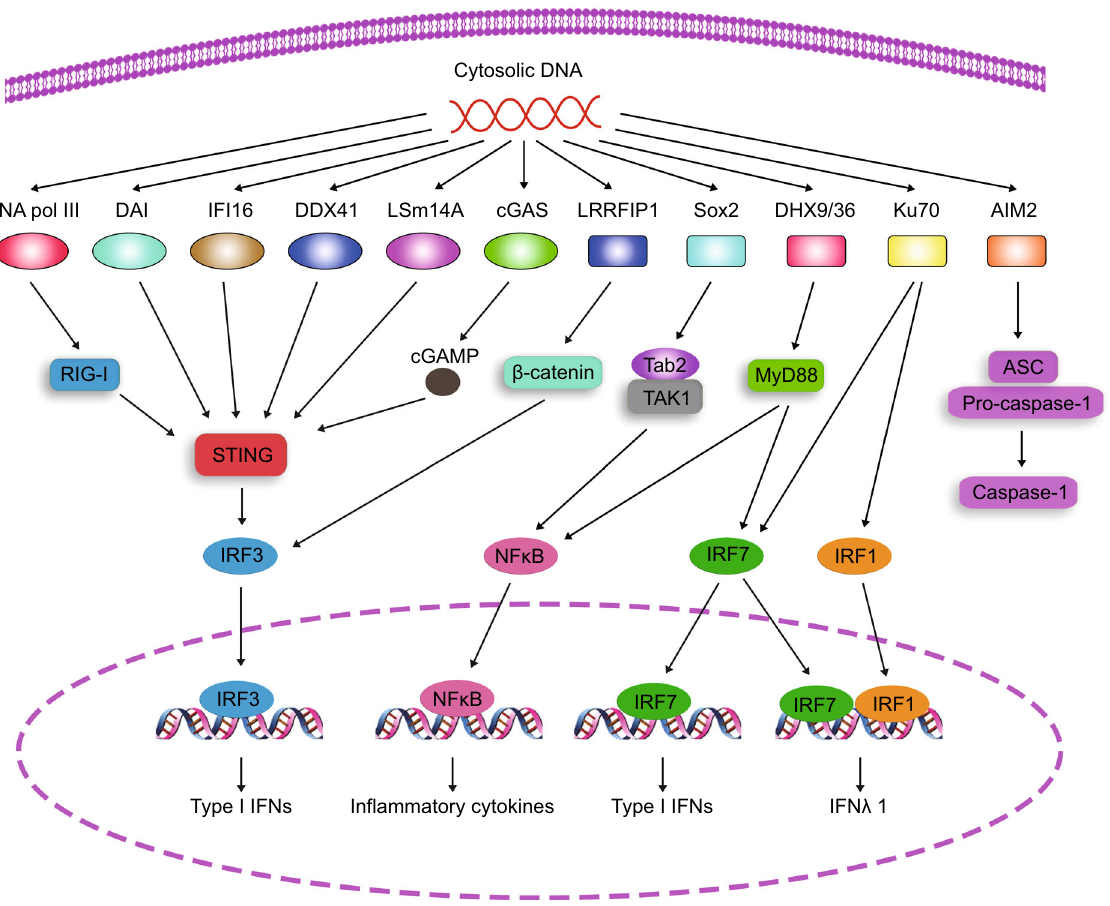
Figure 1. Signaling pathways of cytosolic DNA sensors with DNA challenge. Up to now, many cytosolic DNA sensors have been de fi ned to detect intracellular double-stranded DNAs. RNA polymerase III transcribes AT-rich DNAs into RNAs that are recognized by RNA sensor RIG-I, followed by STING and IRF3 activation. DNA sensors DAI, IFI16, DDX41 and LSm14A sense dsDNA directly to activate STING for type I IFN production. In the presence of dsDNAs, cGAS catalyzes the synthesis of cGAMP, a strong activator of STING. With dsDNAs, LRRFIP1 initiates β -catenin and IRF3 activation in a STING-dependent manner. Other DNA sensors prime immune responses independently of STING. After recognition of dsDNAs, Sox2 triggers the activation of the Tab2/ TAK1 complex in neutrophils. When detected by dsDNAs, DHX9/36 activates NF κ B and IRF7 through MyD88. DNA sensor Ku70 triggers the activation of IRF1 and IRF7. AIM2 initiates the activation of in fl ammasome through ASC with